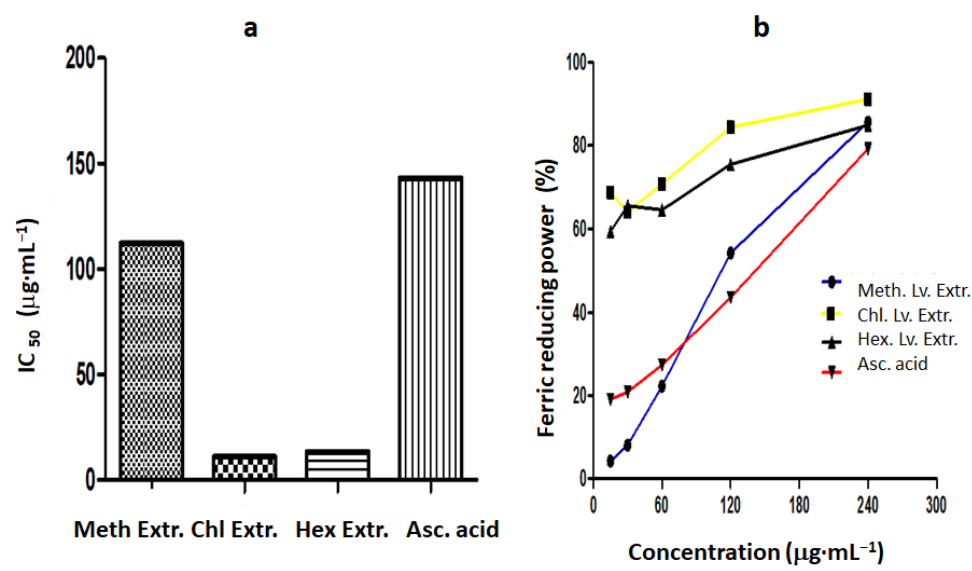
Figure 3. Comparison of ferric-reducing power ( a ) IC 50 values for D. villosa extracts of D. villosa leaf extract in ferric-reducing antioxidant potential ( b ). Chl. = Chloroform; Hex = Hexane, Meth. = Methanol; Lv. = leaves; Extr. = Extract; Asc. Acid= Ascorbic acid.